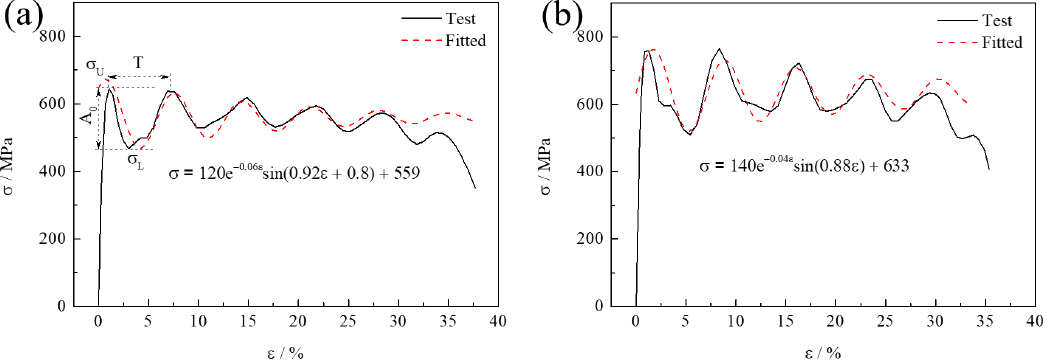
Figure 5. The fluctuation characteristic of stress-strain curves ( a ) Q380 and ( b ) Q420 steels at strain rate of 333 s − 1 , where the first appeared maximum stress is assigned as σ U